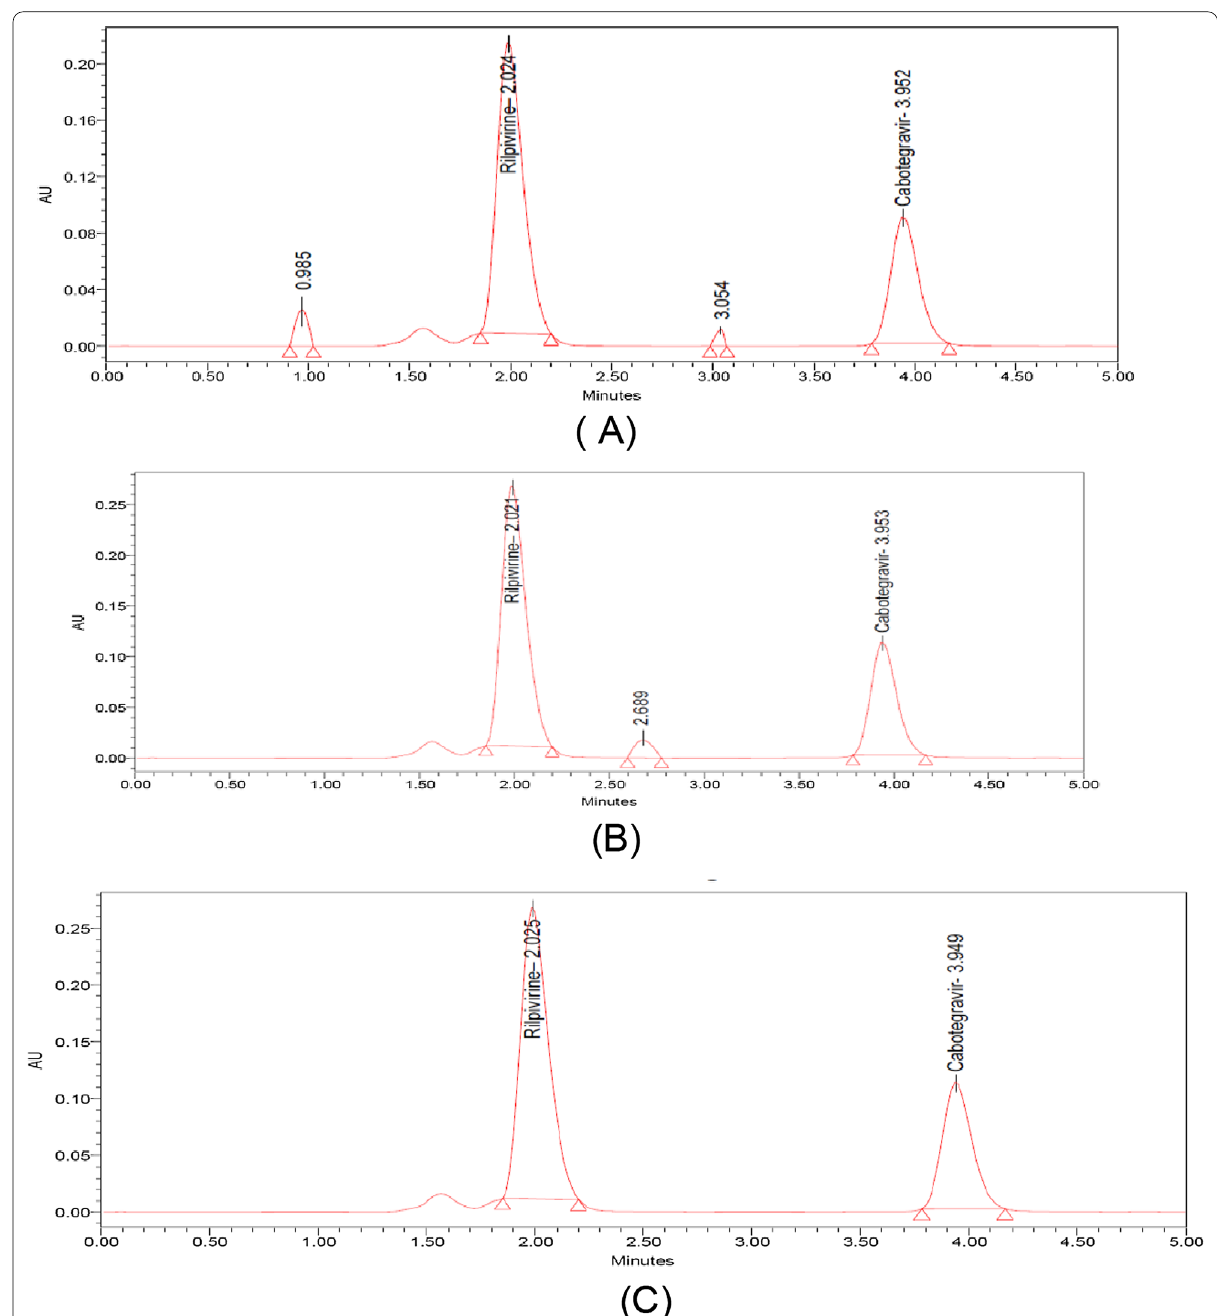
Fig. 5 Forced degradation chromatograms of A acid, B alkali, C control, D peroxide, E photo, F reductive, and G thermal